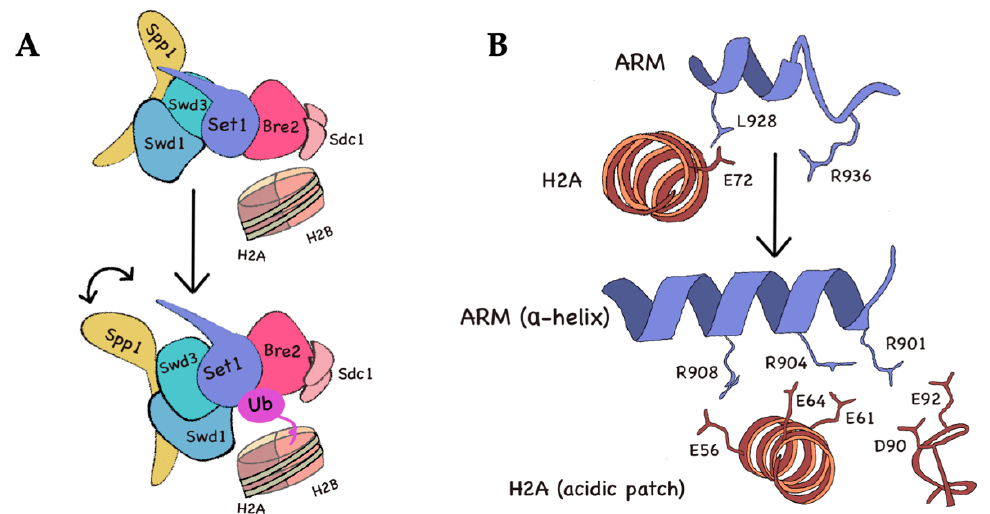
Figure 4. Structural overview of COMPASS upon H2B ubiquitination ( A ) Change of conformation of the COMPASS complex upon ubiquitylation of H2B. Swd1, Swd3, and Spp1 subunits rotate away from the rest of the catalytic module of COMPASS; Swd1 establishes a series of contacts with the ubiquitin that strengthen the interaction and stabilize the conformational change; ( B ) Schematic representation of the arginine-rich motif (ARM) stabilization. The ARM is stabilized by the contact with the ubiquitin, and is able to interact with several residues of the acidic patch of H2A, after having adopted an α -helix conformation, according to Worden et al. [127]. Upon the conformational change adopted by the ARM, the residues participating in the interaction with the acidic patch vary, as indicated.